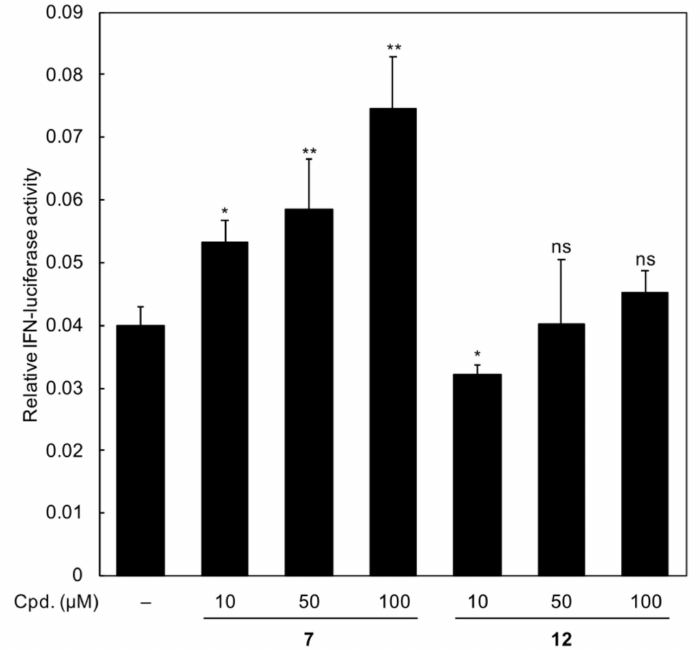
Figure 2. Evaluation of the IFN- β induction activity of compounds 7 and 12 with digitonin perme- abilization. HEK293T cells were transfected with vectors encoding STING, as indicated, together with an IFN-luciferase reporter, and luciferase activity was measured 6 h after stimulation. Data are presented as mean ± SEM ( n = 3). * p < 0.05; ** p < 0.005; and ns mean statistically no significance when compared with the DMSO-treated control in a Student’s t-test. Abbreviations: IFN; interferon, DMSO; dimethyl